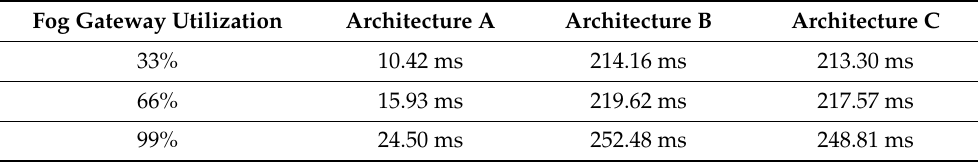
Table 6. The simulation results for different